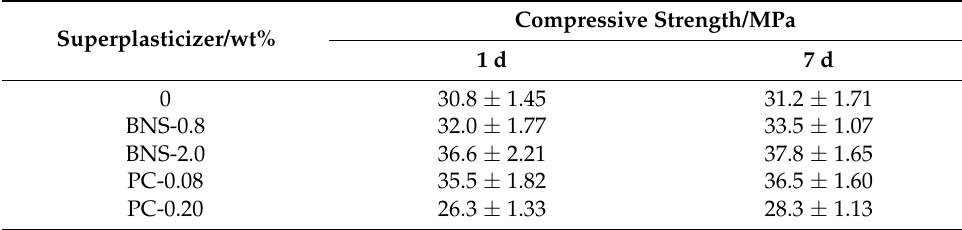
and 7d both increased whether the BNS superplasticizer was 0.8% or 2.0%. In contrast, the C 4 A 3 S(cid:3364) mortars compressive strength of the PC superplasticizer decreased at maximum content of 0.20%. Table 5. Compressive strength of C 4 A 3 S Table 5. Compressive strength of C 4 A 3 S(cid:3364) mortars.